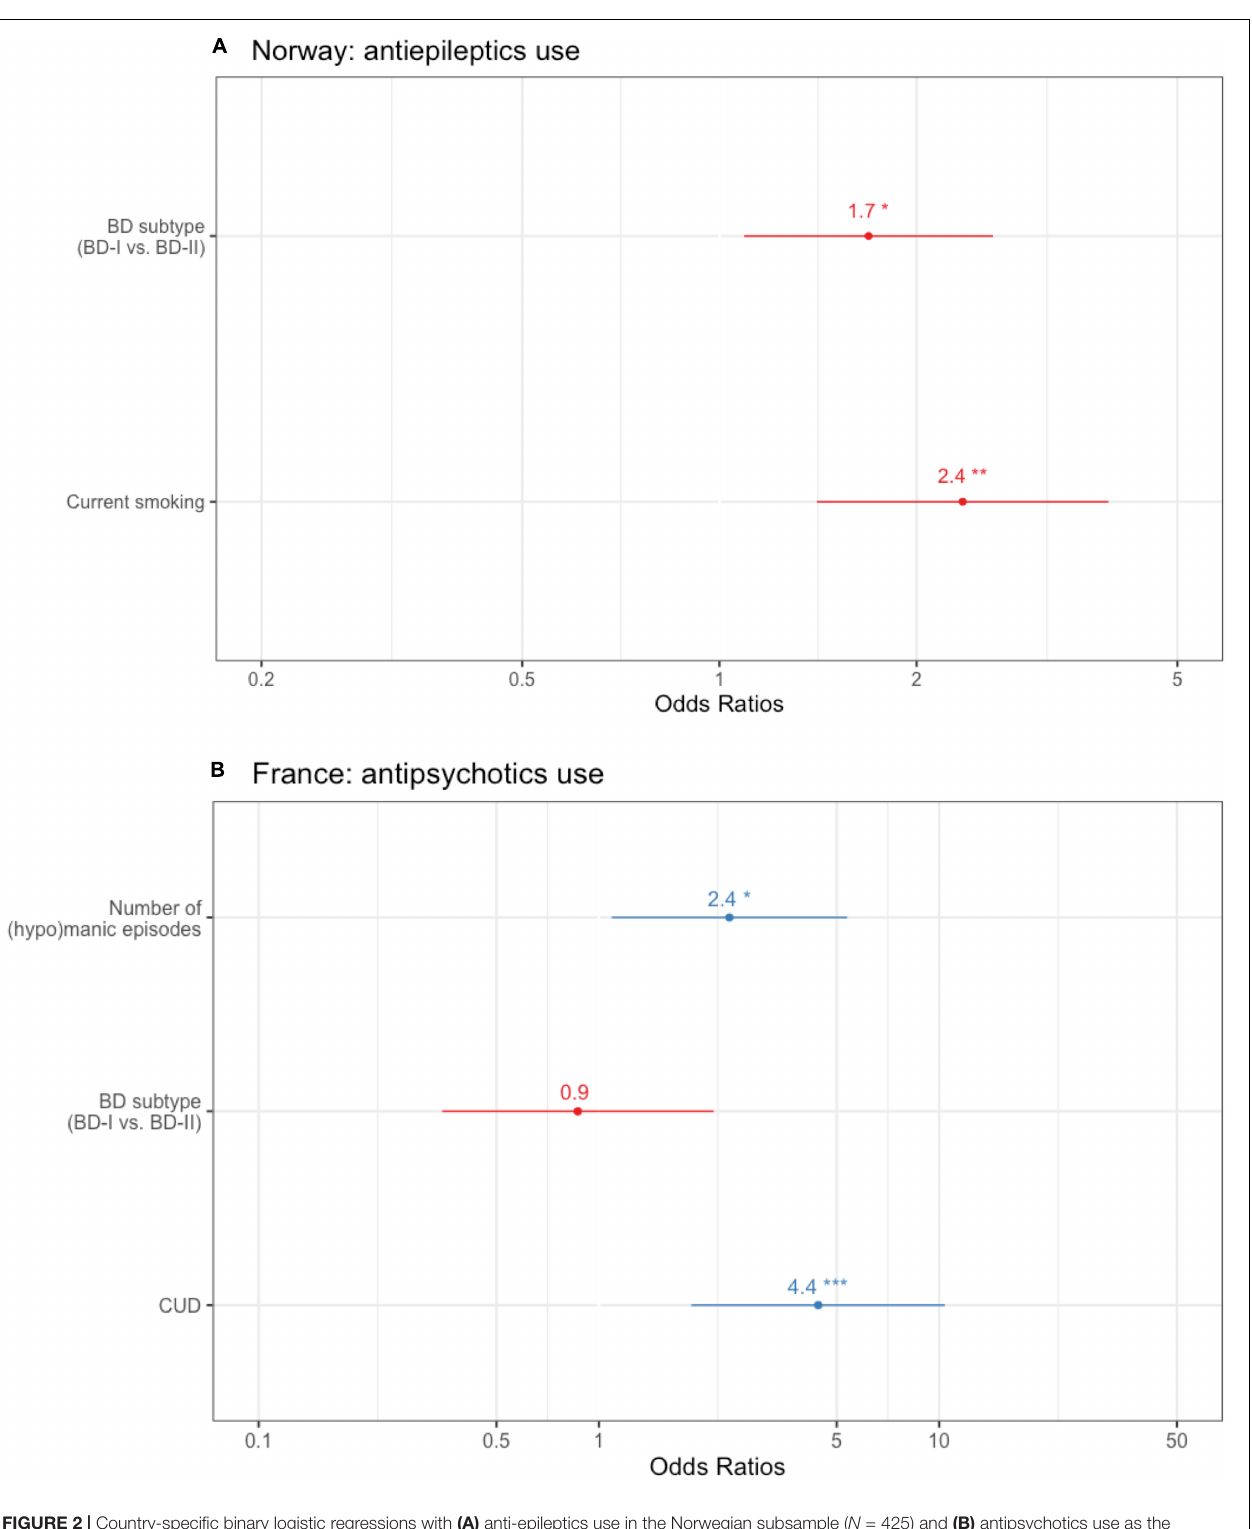
Frontiers in Psychiatry |